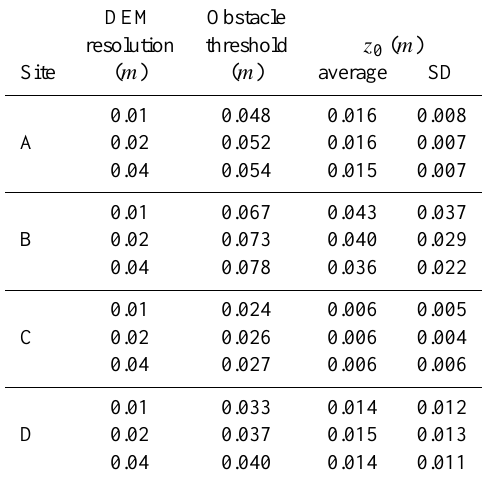
Figure 4. The effect of obstacle threshold ( m ) on both obstacle density and the estimate of surface roughness using the alternative method for Sites A–D and the DEMs with a resolution of 0.01m. Table 3. Surface roughness ( z 0 ) estimates and obstacle thresholds as a function of DEM resolution ( m ) at Sites